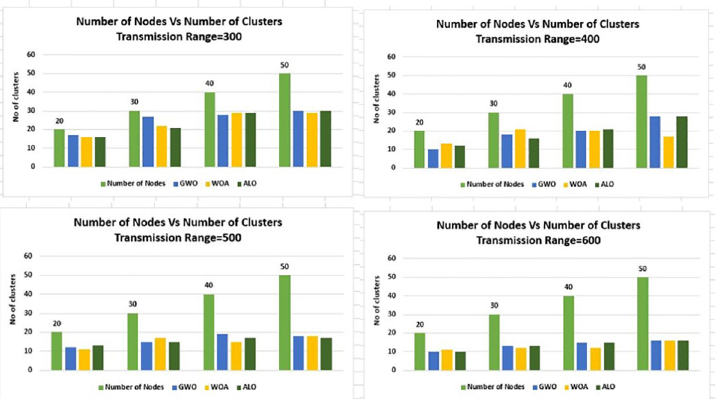
Fig 12. Node density versus number of clusters for transmission range 300m-600m & grid 3Km × 3Km.